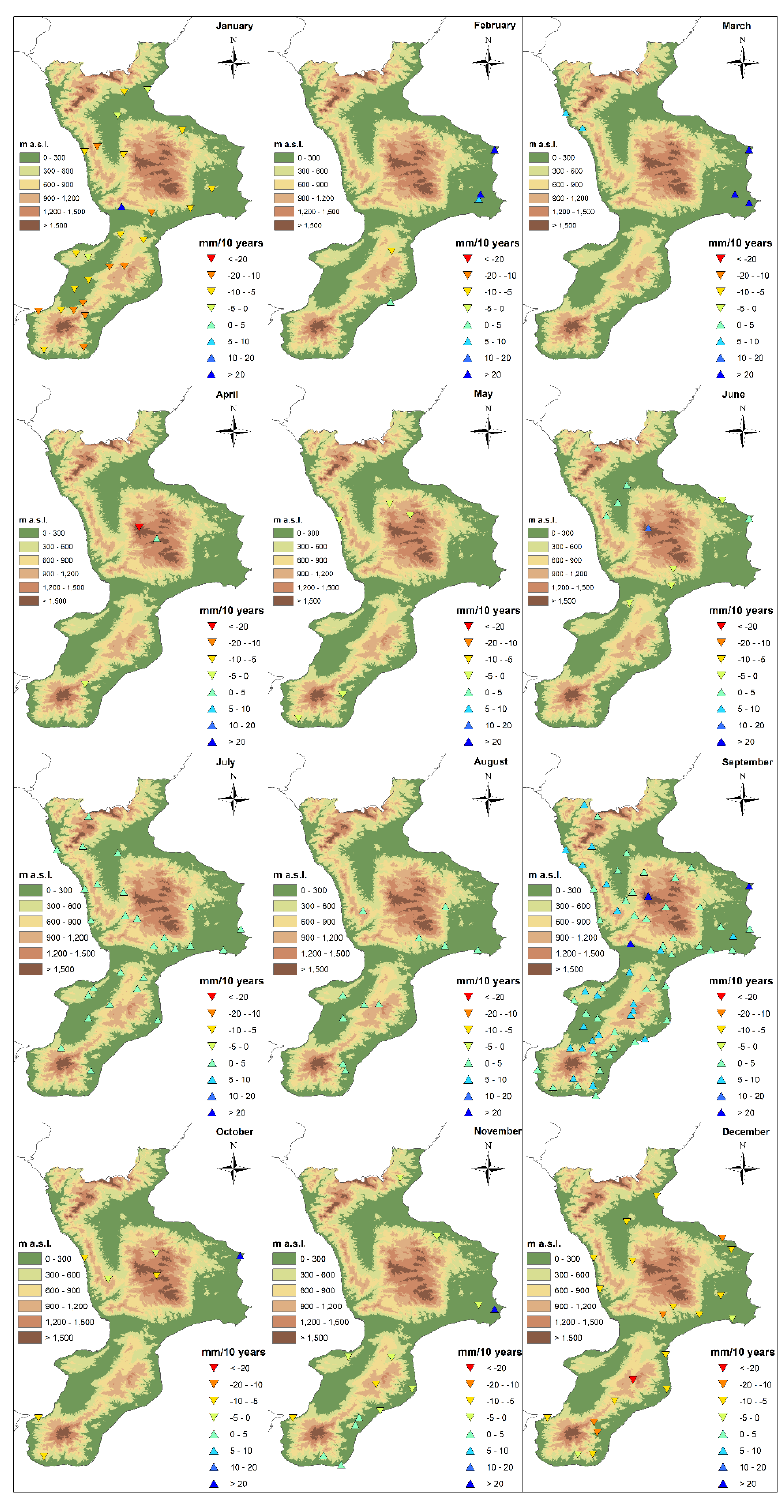
Figure 4. Spatial distribution of the rain gauges showing positive or negative monthly rainfall trends.